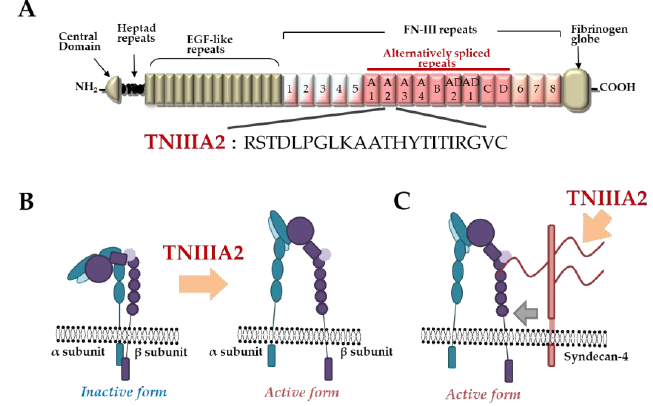
Figure 1. Tenascin-C (TNC)-derived TNIIIA2 fragments / peptides. ( A ) Schematic illustration of TNC and amino acid sequence of proadhesive peptide TNIIIA2. ( B ) Conformational shift of integrin activation by peptide TNIIIA2. ( C ) Lateral interaction of integrin with syndecan-4 ectodomain by peptide TNIIIA2. Molecules 2020 , 25 , x FOR PEER REVIEW